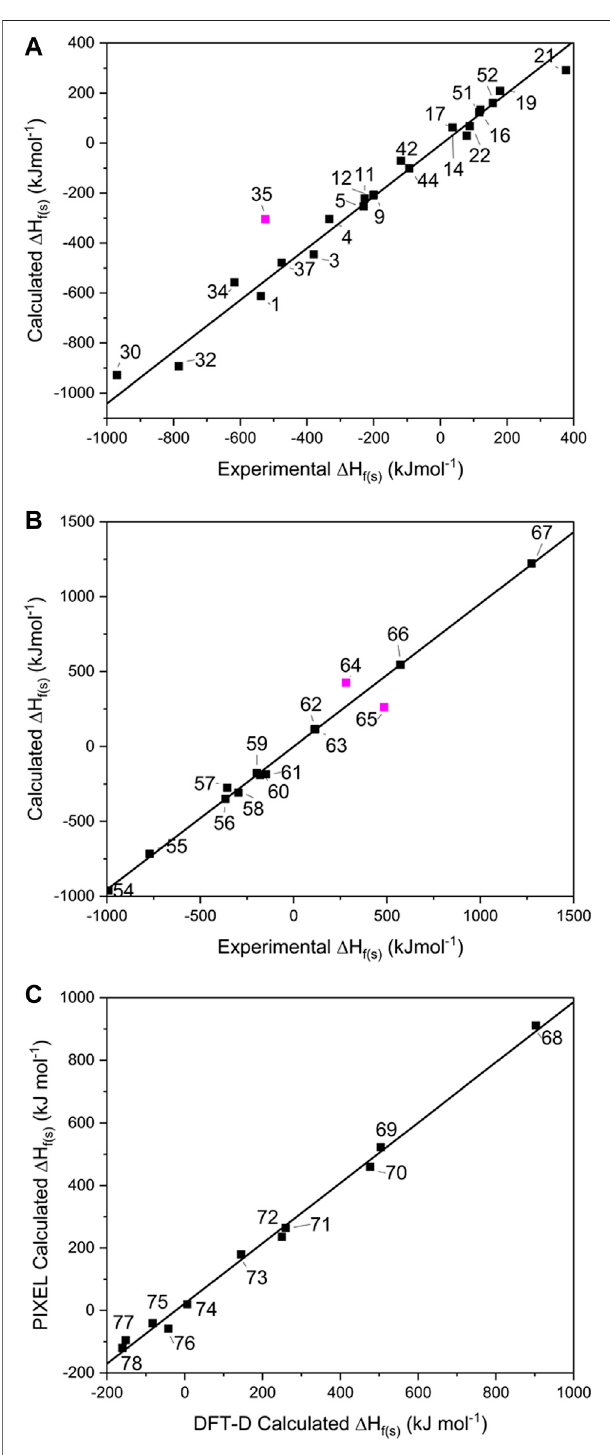
FIGURE3| Showingthecalculatedsolidheatsofformationfor (A) single component crystals, (B) salts and (C) co-crystals. Data points omitted from the lines of best fi t are shown in